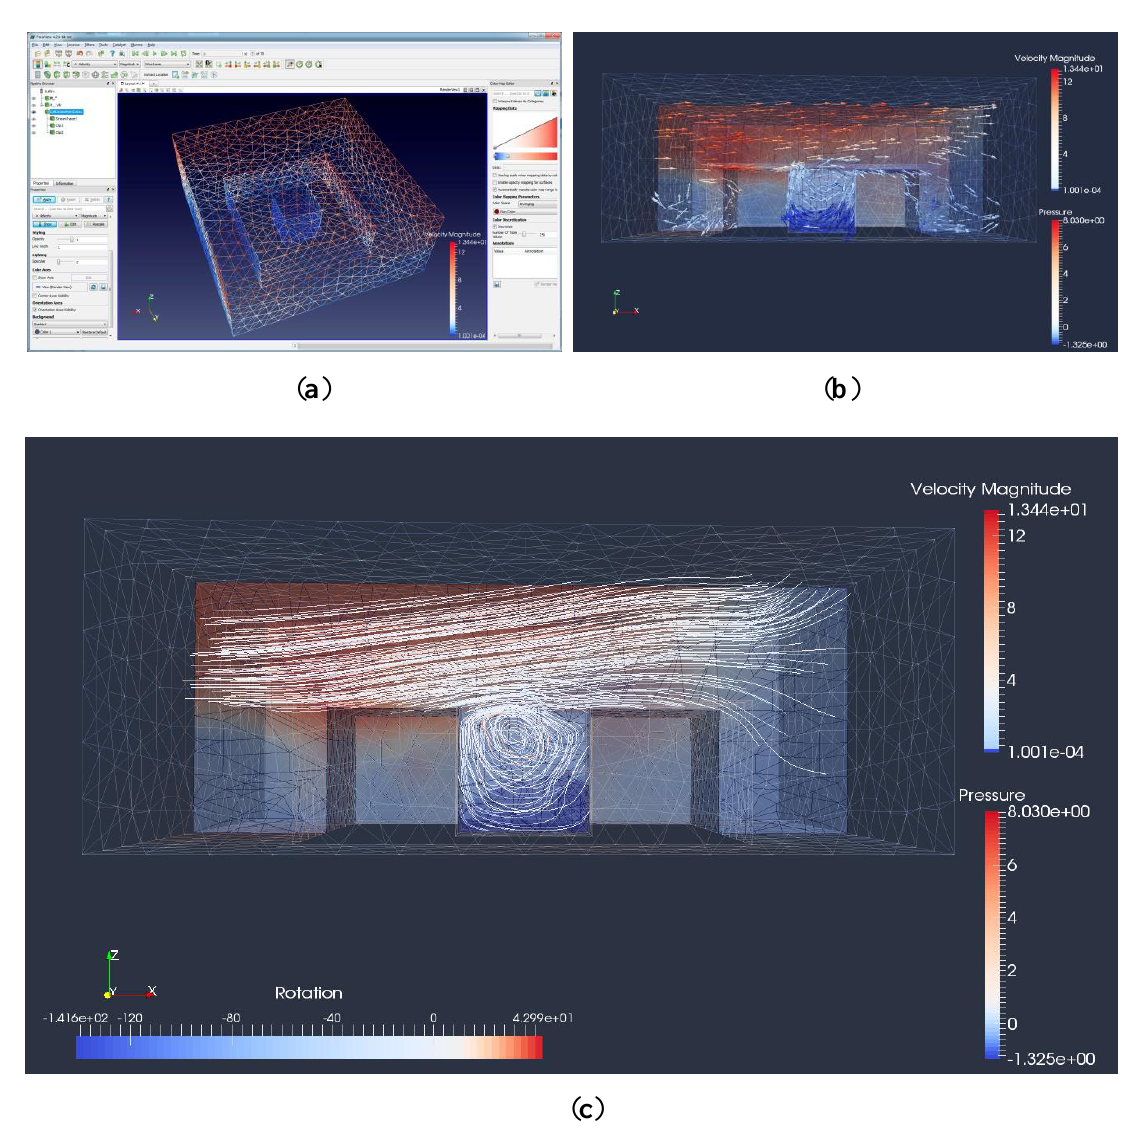
Figure 9. Results of the case study displayed by Paraview, a to c process steps. ( a ): general meshing view, ( b ) and ( c ): simulation results representing the vector field ( b ) and stream lines ( c ).